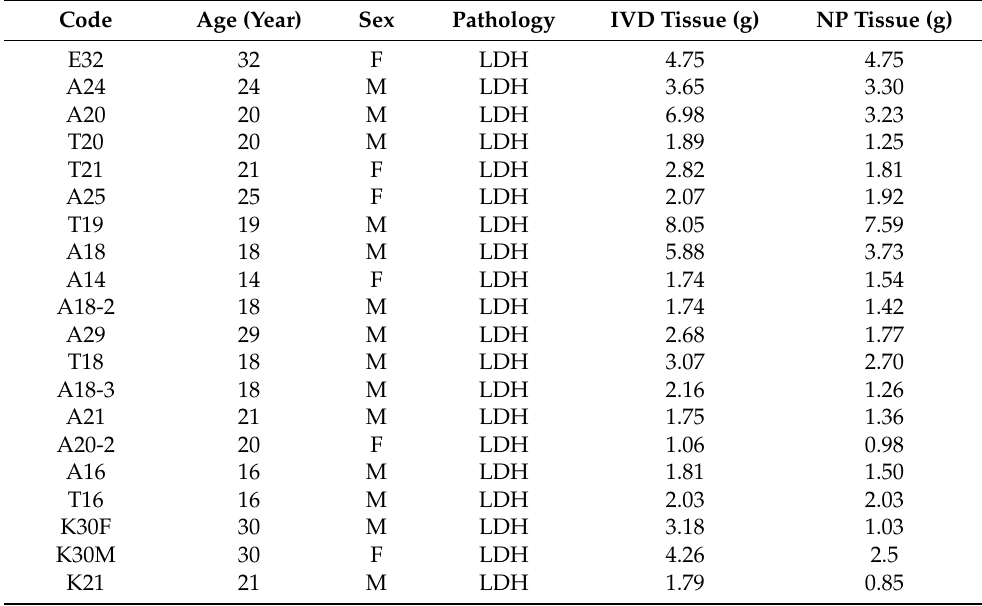
Table 1. Details of clinical samples. Age, sex, total weight of IVD tissue collected at the time of surgery, and weight of NP tissue after selection are listed for each sample. LDH: lumber disc hernia, IVD: intervertebral disc, NP: nucleus